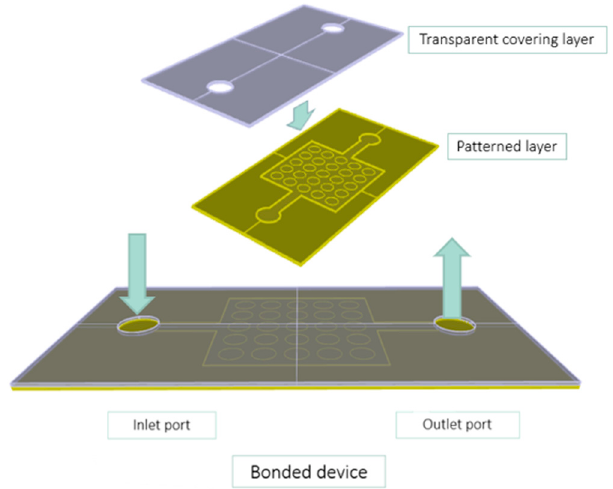
Figure 2. Sandwich structure of a microfluidic device, showing the two bonded layers. The patterned layer reproduces the designed geometrical features. The covering layer confines the fluid, typically hosts the inlet and outlet ports and allows for the visualization of the pore-scale phenomena. Inlet and outlet ports can also be carved out of the patterned layer.